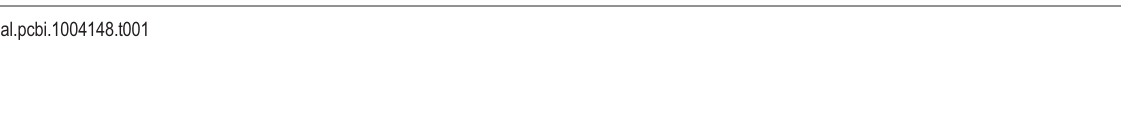
Best estimate of the fraction of each homo-dimeric arrangement and its (2.5%,97.5%) con fi dence intervals (in parenthesis) are calculated as reported in the Methods